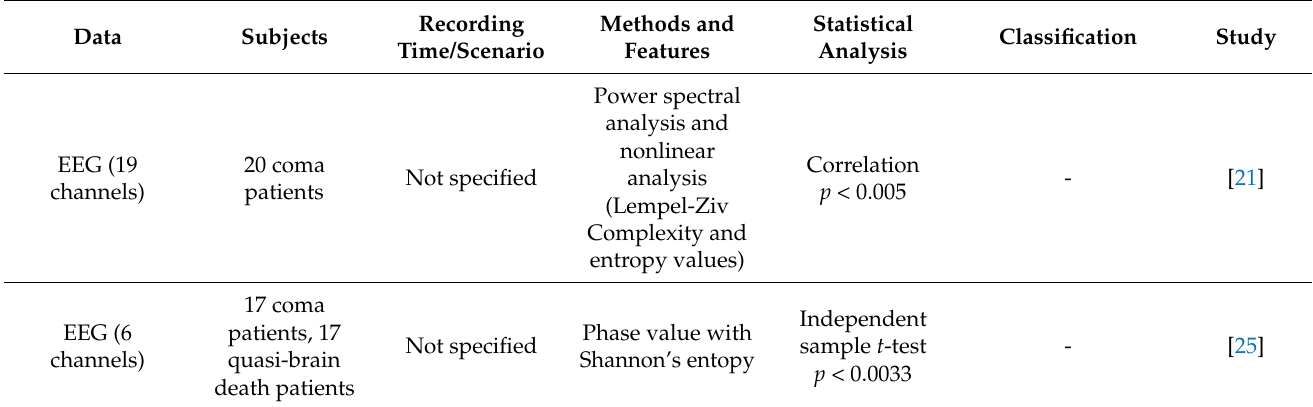
Table 9. Some of the studies aimed at differentiating coma